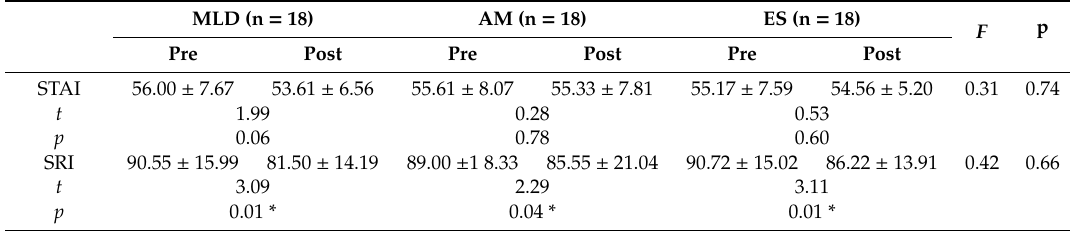
Table 5. Anxiety and stress t-test and ANOVA analyses (N = 54).